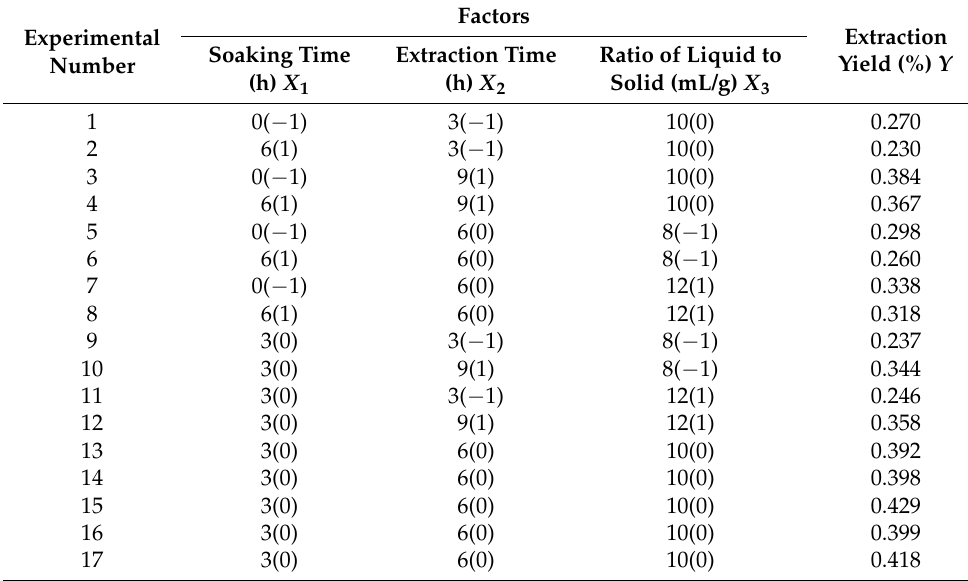
Table 2. Box-Behnken design (BBD) for Polygonum orientale essential oil extraction.